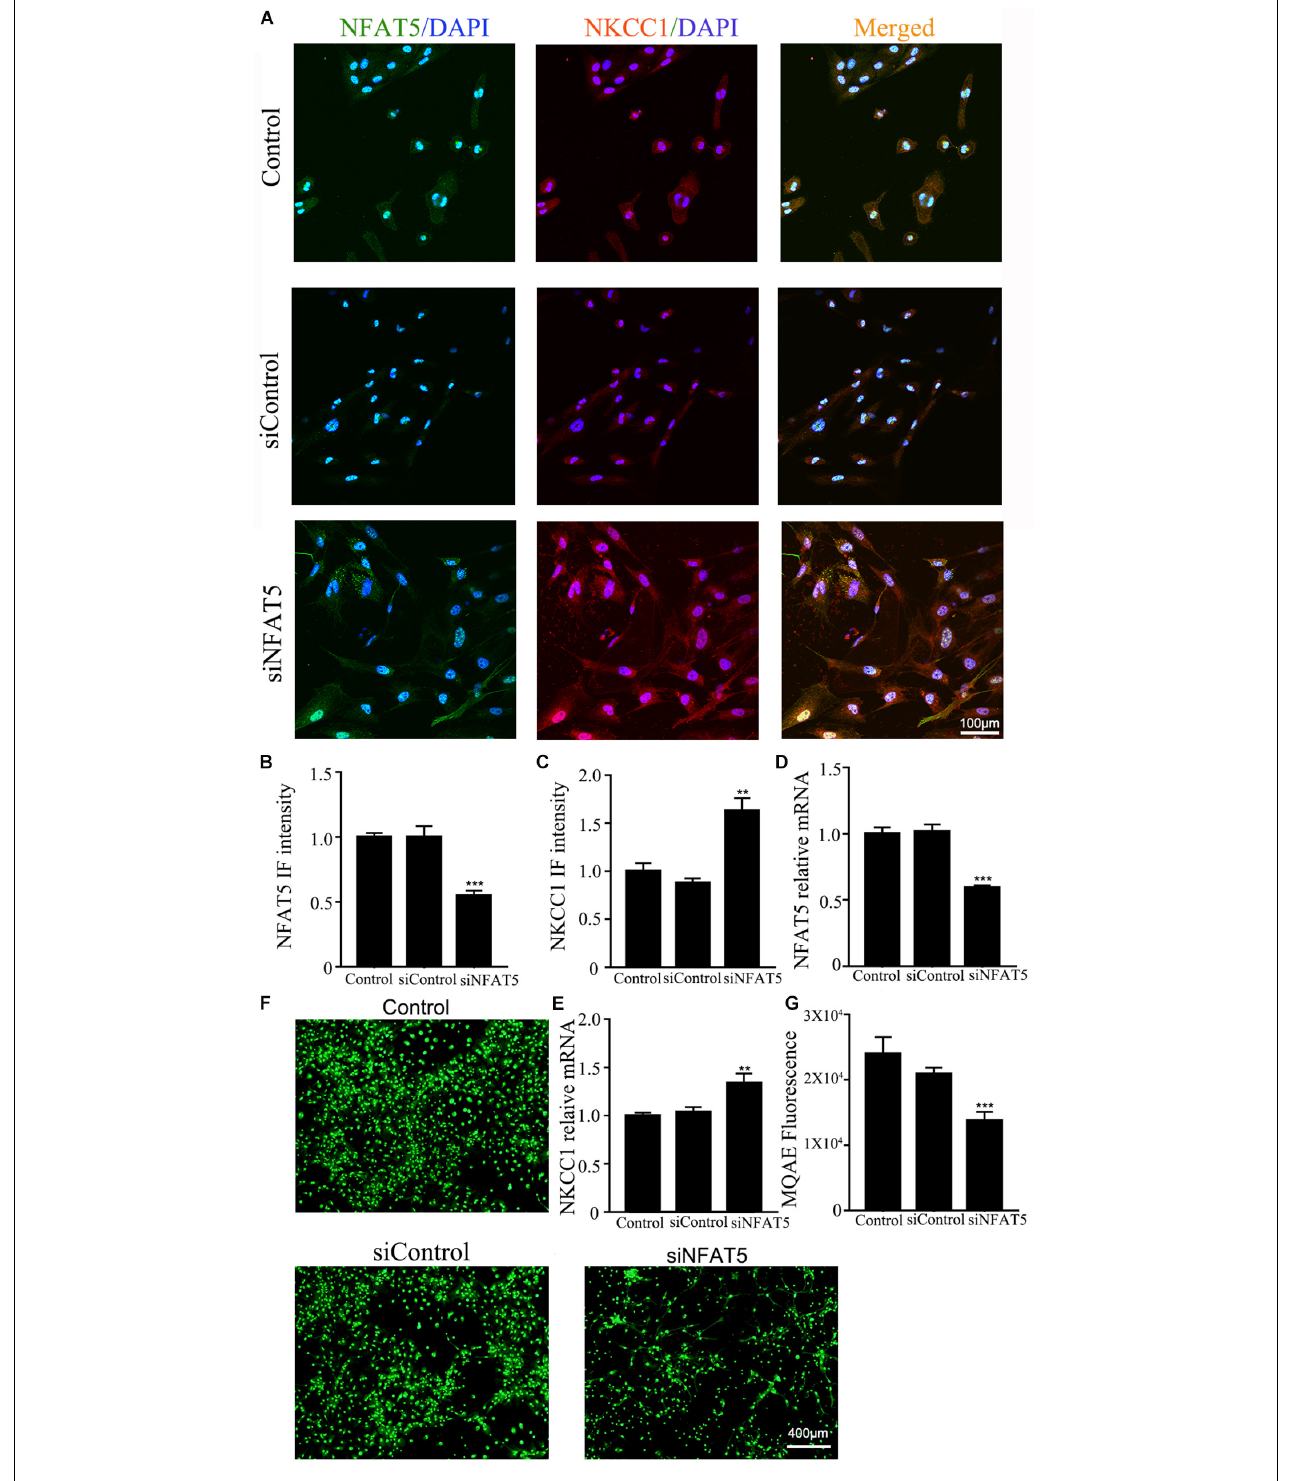
FIGURE 4 | NAFT5 knock down upregulated NKCC1 expression. (A) Confocal image demonstrating NKCC1 expression in neurons after transfection with NFAT5-specific siRNA. (B,C) The intensity of NFAT5 and NKCC1 fluorescence were determined in 10 fields/well and divided by the number of cells counterstained with DAPI. (D,E) NFAT5 and NKCC1 mRNA expression level in neurons at 36hr after transfection. (F,G) Fluorescence imaging of Cl − via MQAE staining in neurons. The green fluorescence indicates the fluorescence intensity of MQAE. The values represent the mean ± SEM. ∗∗ p < 0.01, ∗∗∗ p < 0.001 versus control (Tukey’s test after one-way